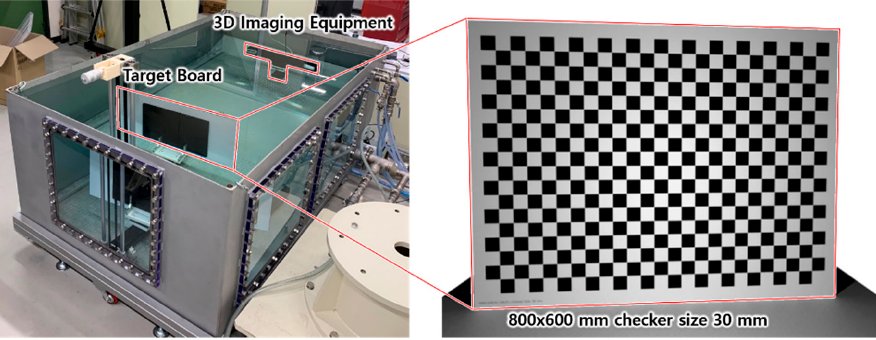
Figure 17. Experimental setup.